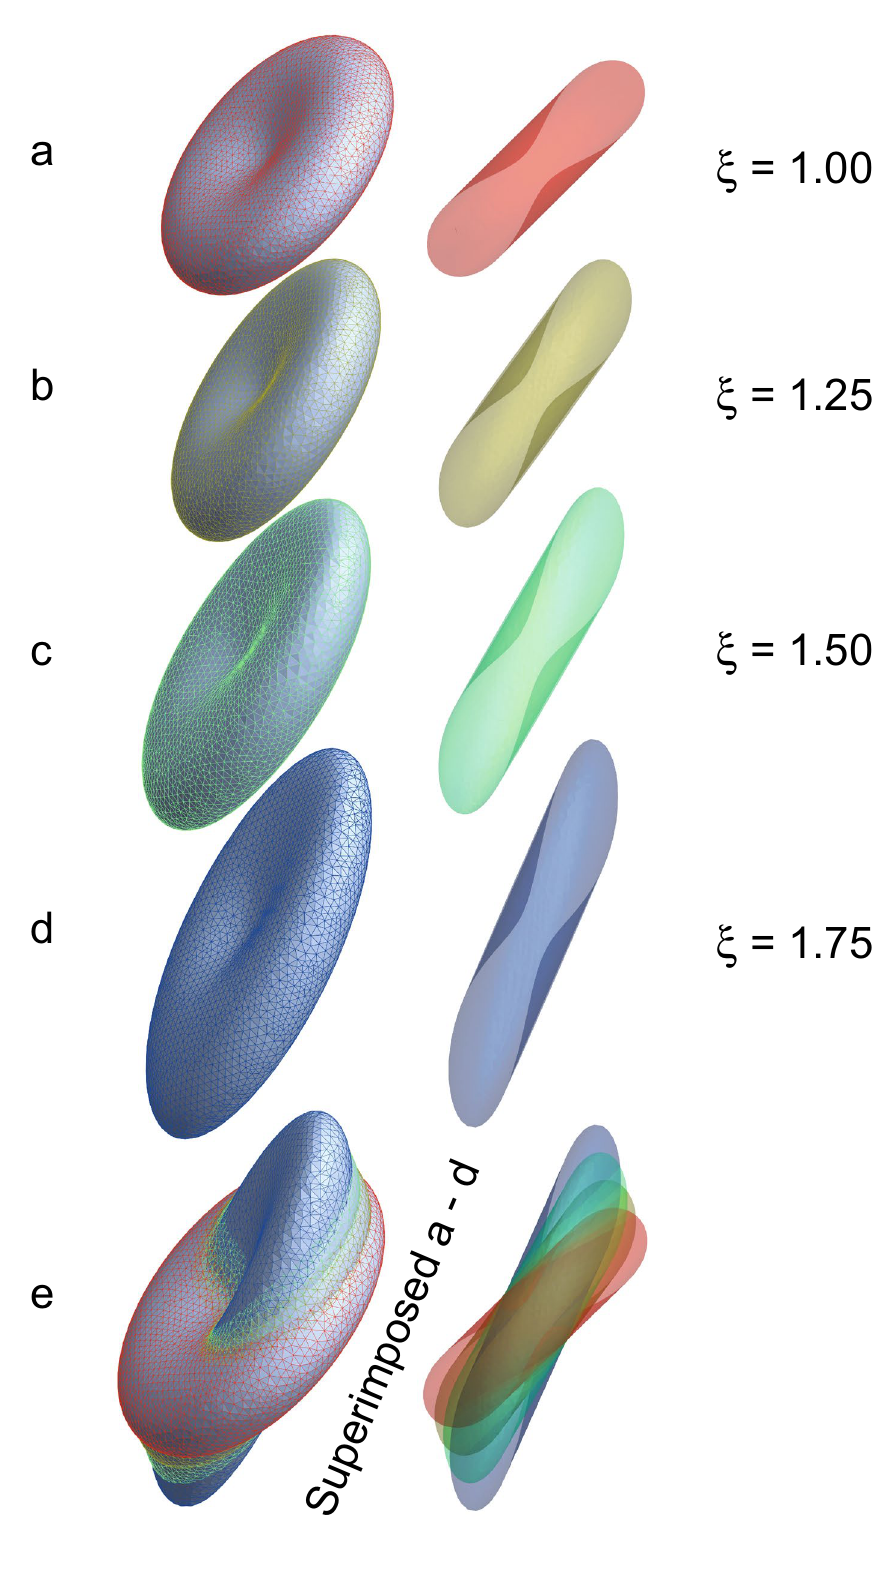
Figure 4. RBC rotated through 45° about the x-axis, relative to a linear strain field imposed in the z -direction. The relaxed RBC ( a ) had the same dimensions as in Fig. 1 (in fact, as in all the figures in this article): ( a ) No elongation, ξ = 1.00; ( b ) stretched by 25%, ξ = 1.25; ( c ) stretched by 50%, ξ = 1.50; ( d ) stretched by 75%, ξ = 1.75; and ( e ) showing the relative elongation and concomitant narrowing of the RBCs by superimposing the images. Colour coding was used to provide distinction between the RBCs in ( e ). In the boundary discretization MaxCellMeasure was set to 0.1 giving ~ 8000 mesh